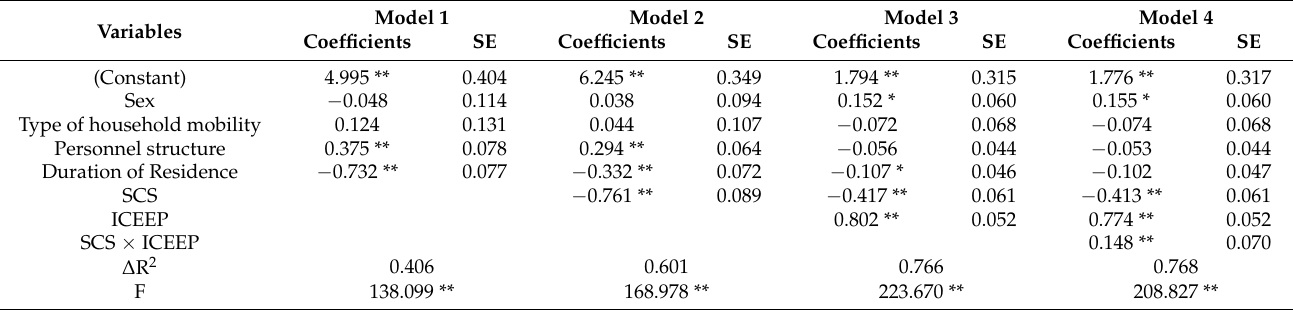
Table 5. Moderating effect of ICEEP on the relationship between SCS and IE.